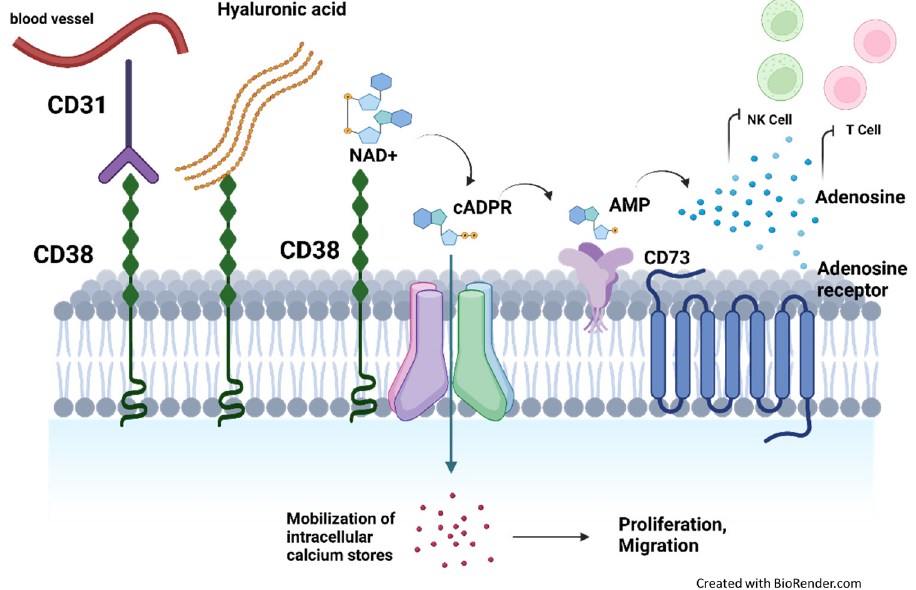
Figure 1. Functional roles of CD38. CD38 can mediate adhesion through binding with (1) hyaluronic acid in the extracellular matrix or through (2) binding with its cognate ligand CD31 to mediate adhesion and transendothelial migration. (3) Importantly, the ecto-enzymatic domain of CD38 catabolizes NAD+ into cADPR, which can enter the cell to mobilize calcium stores and modulate numerous cell signaling pathways. cADPR can also be hydrolyzed to ADPR, and then subsequently adenosine upon colocalization with CD73/203a. Adenosine is bound to purinergic receptors to suppress NK and T-cell activation.